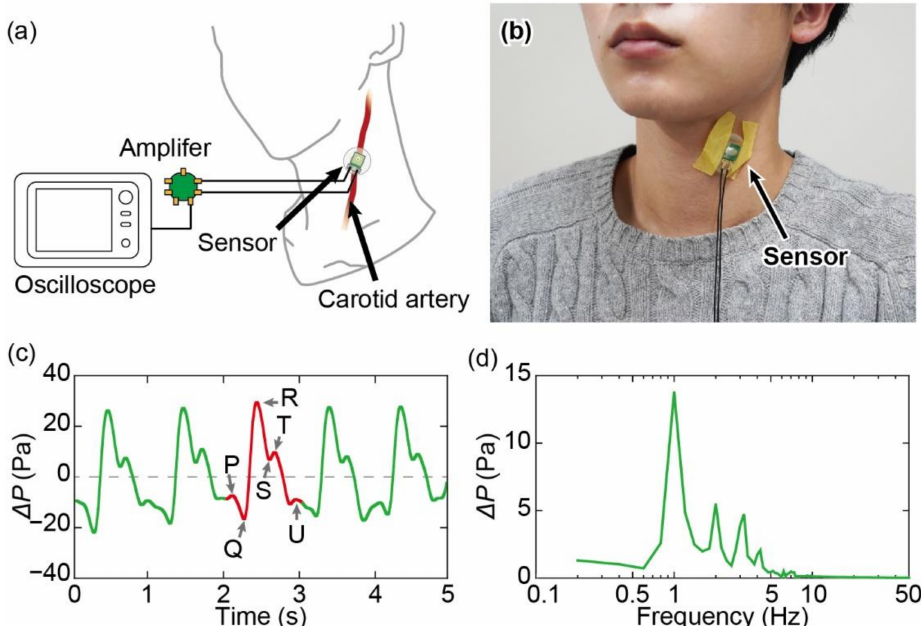
Figure 9. ( a ) Illustration and ( b ) photograph of measurement of pulse wave using developed sensor. ( c ) Response of sensor to pulse wave. ( d ) FFT analysis of measured